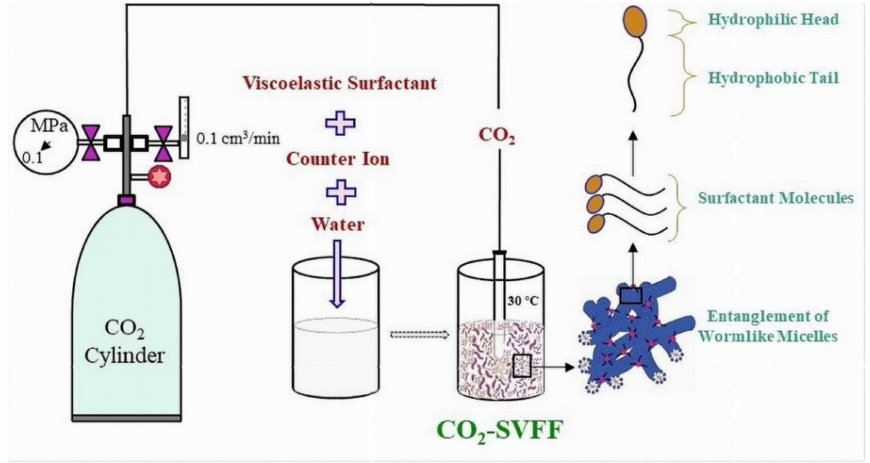
Figure 2. Sketch diagram displaying the preparation process of CO 2